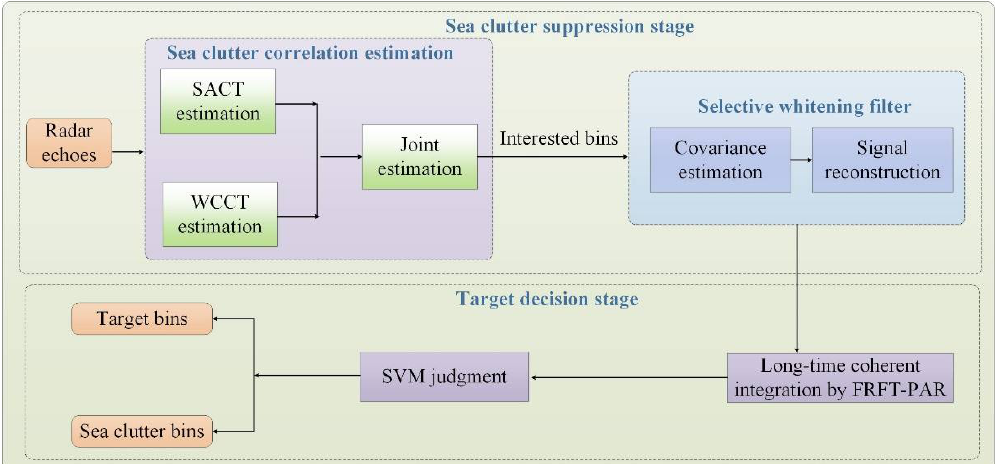
Figure 1. Flow chart of the proposed algorithm.